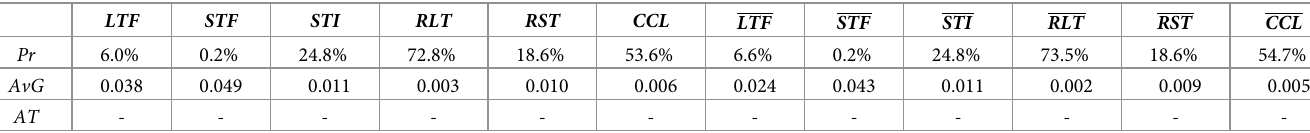
Table 6. Overview of Pr , AvG , and AT for all proposed algorithms.